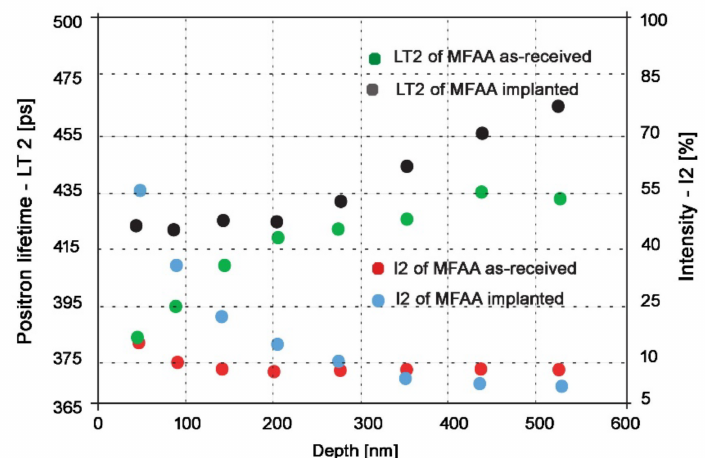
Figure 5. Positron lifetimes (LT 2 ) and intensity of annihilation (I 2 ) in defects for various energies of incident positrons (penetration depth) for both non-irradiated and proton-irradiated